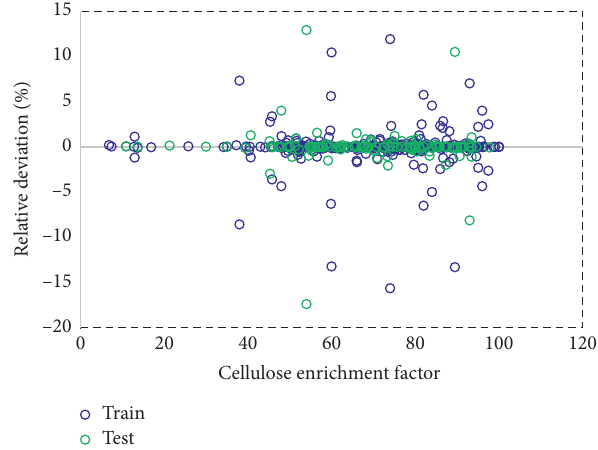
Figure 7: The relative deviation analysis on the CEF output values.